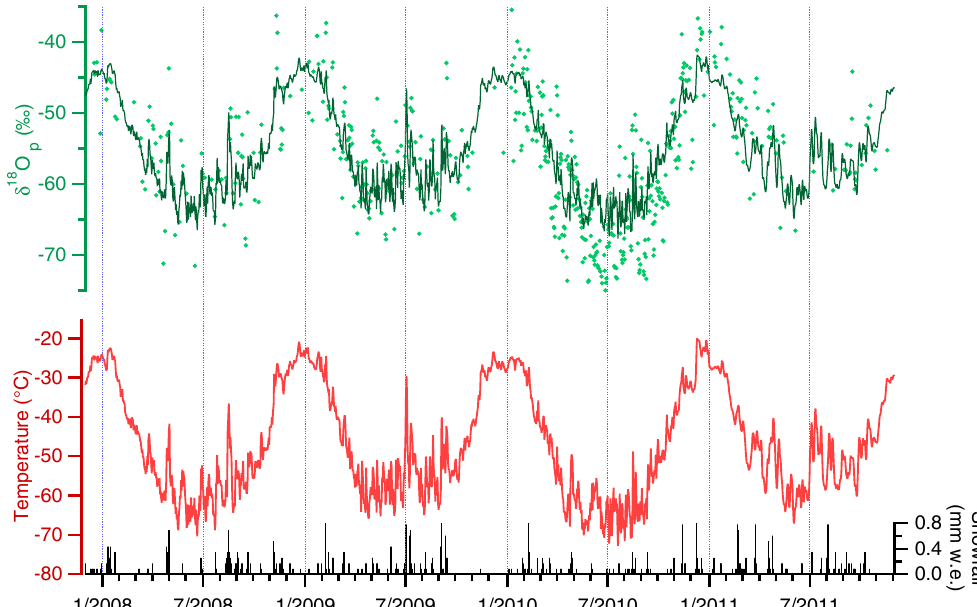
Figure A1. Comparison of isotopic composition of the precipitation (light green points) and simulated isotopic composition (dark green line) from the temperature (red) from